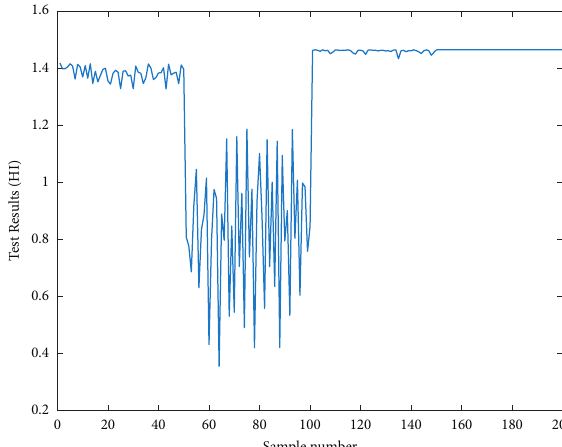
Figure 6: Evaluation chart of OWT without feature